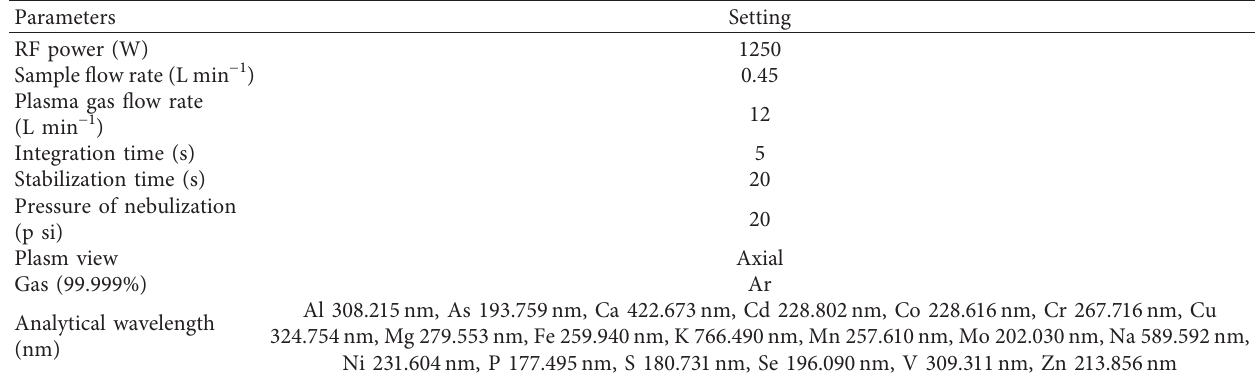
Table 2: Instrumental analytical conditions for ICP OES of element analyses.